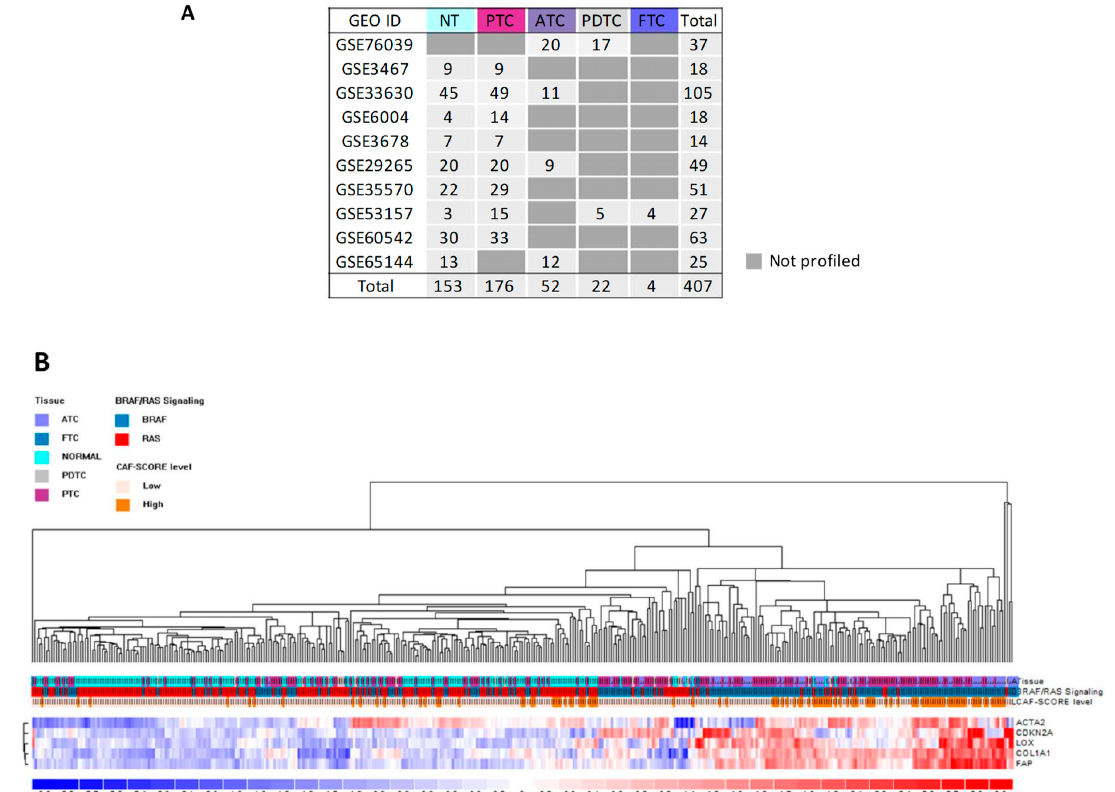
Figure 6. Assessment of tumoral and stromal derived genes in human thyroid cancers gene sets derived from Gene Expression Omnibus (GEO). ( A ) Gene sets description. ( B ) Unsupervised hierarchical clustering analysis of 407 samples derived from GEO datasets on five tumoral and stromal genes. The color scale bar represents the relative gene expression level normalized by the standard deviation. Color legend for the tissue, BRAF-like / RAS-like signaling, and CAF score is reported. α -SMA and p16 are indicated by the corresponding gene symbol, ACTA2 and CDKN2A, respectively.